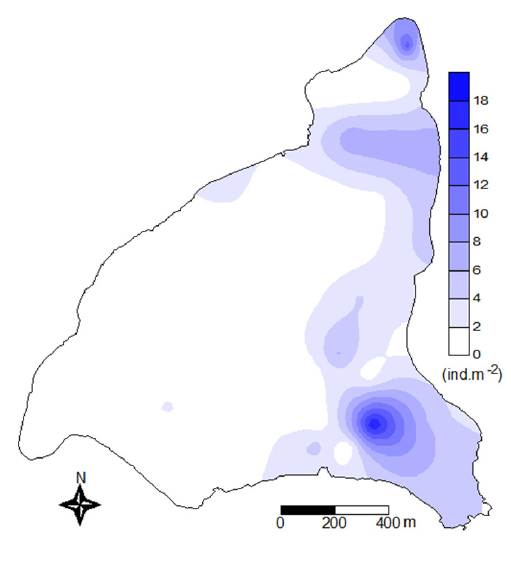
Figure 7. Surface model (kriging) of fish-targets density distribution per unit area (ind.m –2 ) derived from echo- integration data collected in Lagoa Santa, April 28, 2008. Data obtained by probing with the Biosonics